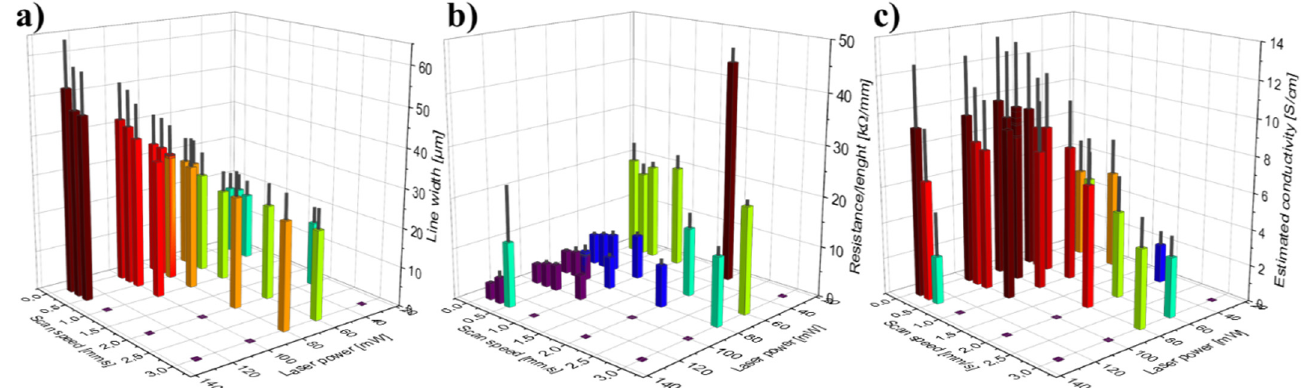
Figure 9. Bar plots of ( a ) corrected line width, ( b ) line resistance, and ( c ) estimated conductivity vs. scan speed and laser power ( n = 4). The flat, purple squares indicate that conductive lines were not formed at these settings.